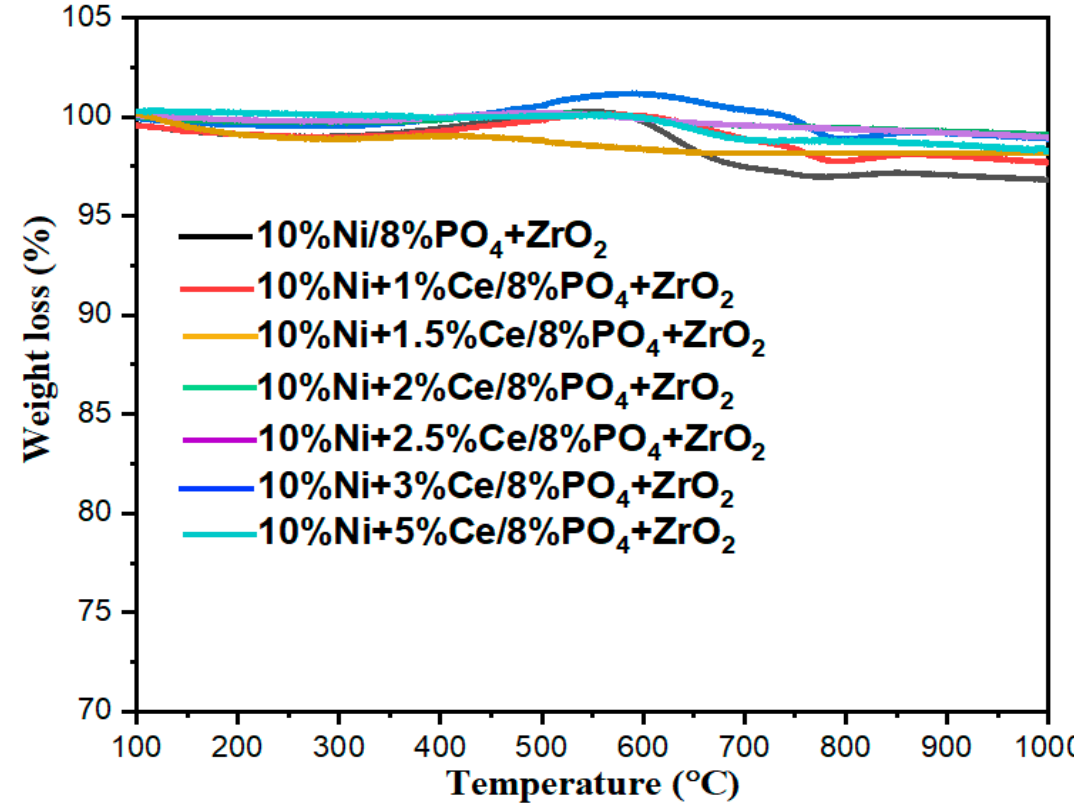
Figure 6. Thermogravimetric (TGA) results of the spent catalysts with 700, 600, and 800 °C activation, calcination, and reaction temperatures, respectively.